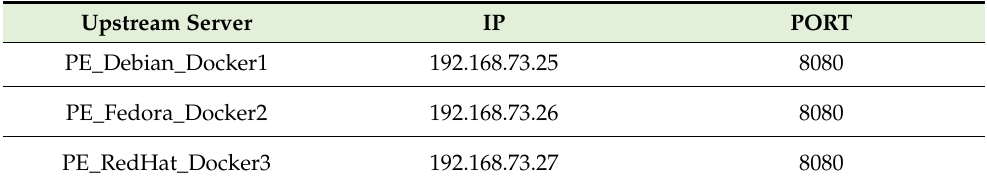
Table 4. Policy engine information.